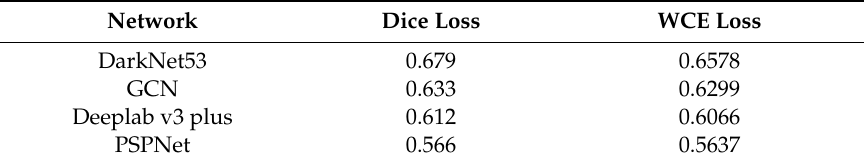
Table 2. Results of wall segmentation without R-FP datasets. Note: WCE = weighted cross entropy;